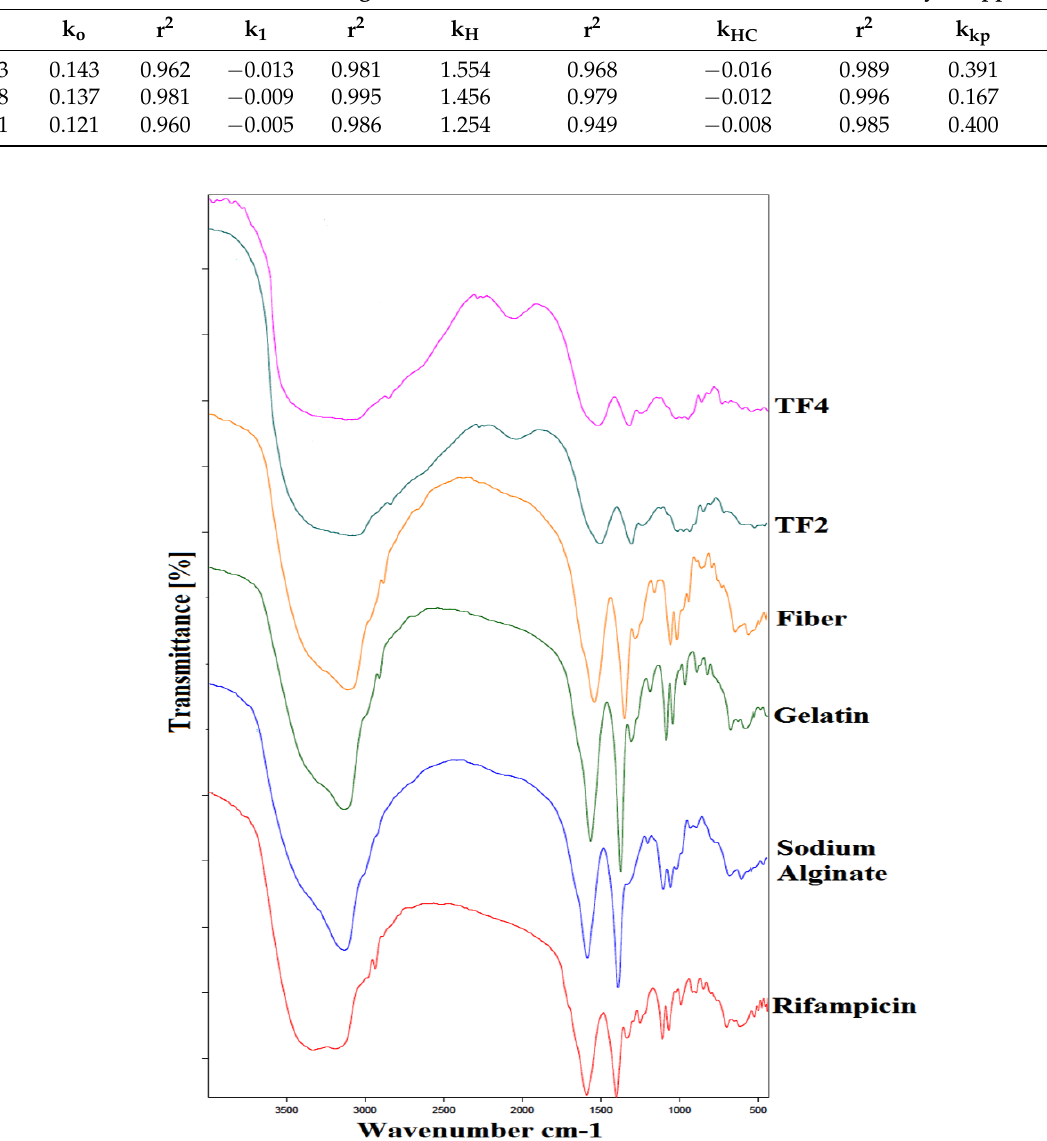
Table 5. In vitro drug release (kinetic modeling) data of various transdermal film batches.